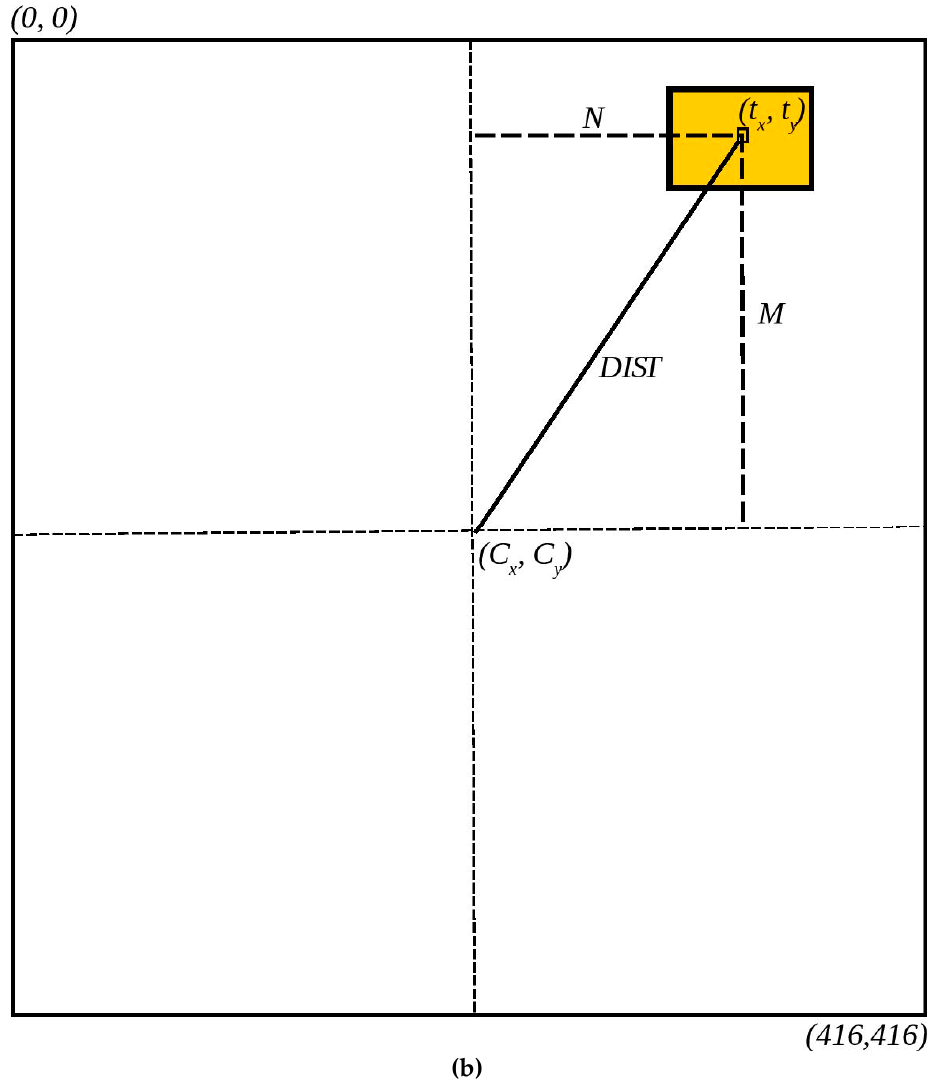
Figure 8. Rescue UAV’s camera field of view (FoV) ( a ) The proportion between sides N , M and ( b ) speeds t x , t y on x , y axes.